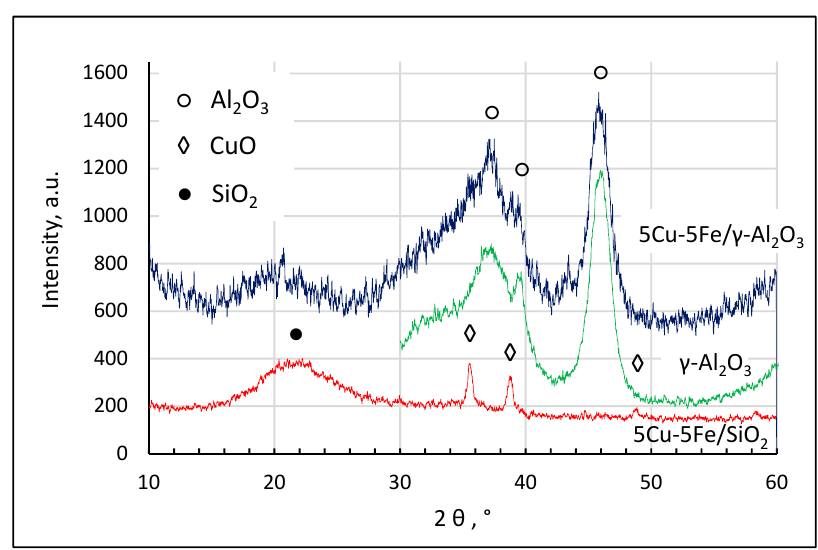
Figure 1. XRD profiles of the calcined 5%Cu-5%Fe/carrier catalysts and alumina carrier. To study the electronic states of Cu and Fe, some representative catalysts were further characterized by DRIFTS using CO as a probe molecule. Figure 2 shows DRIFT-CO spectra as a function of time when calcined Cu-Fe samples are exposed to 16 Torr CO. A band of very weak intensity at 2360 cm − 1 arises in the spectra of this sample, which is characteristic of adsorbed CO 2 and indicates CO oxidation with lattice oxygen on Fe 3+ sites, which are thereby reduced to Fe 2+ ions [22]. Obviously, a high-frequency band at 2127 cm − 1 was observed on the calcined 5%Cu-5%Fe/SiO 2 sample, which corresponds to CO linearly adsorbed on the copper species Cu + [23–25]. For the catalyst 5%Cu-5%Fe/Al 2 O 3 , the intensity of the band was enhanced substan- tially, and the position shifted to a low wavenumber, namely to 2118 cm − 1 , compared with that on the 5%Cu-5%Fe/SiO 2 sample (Figure 2). The band at 2118 cm − 1 characterizes linear carbonyl on electron-deficient copper cations (Cu δ + -CO) [26]. The presence of this band likely indicates strong interaction of copper and iron species in the 5%Cu-5%Fe/Al 2 O 3 sample, which is also consistent with the TPR-H 2 results for this catalyst (to be discussed below). The band position at 2190 cm − 1 agrees with the assignment to CO adsorbed on Al 3+ cations [27].